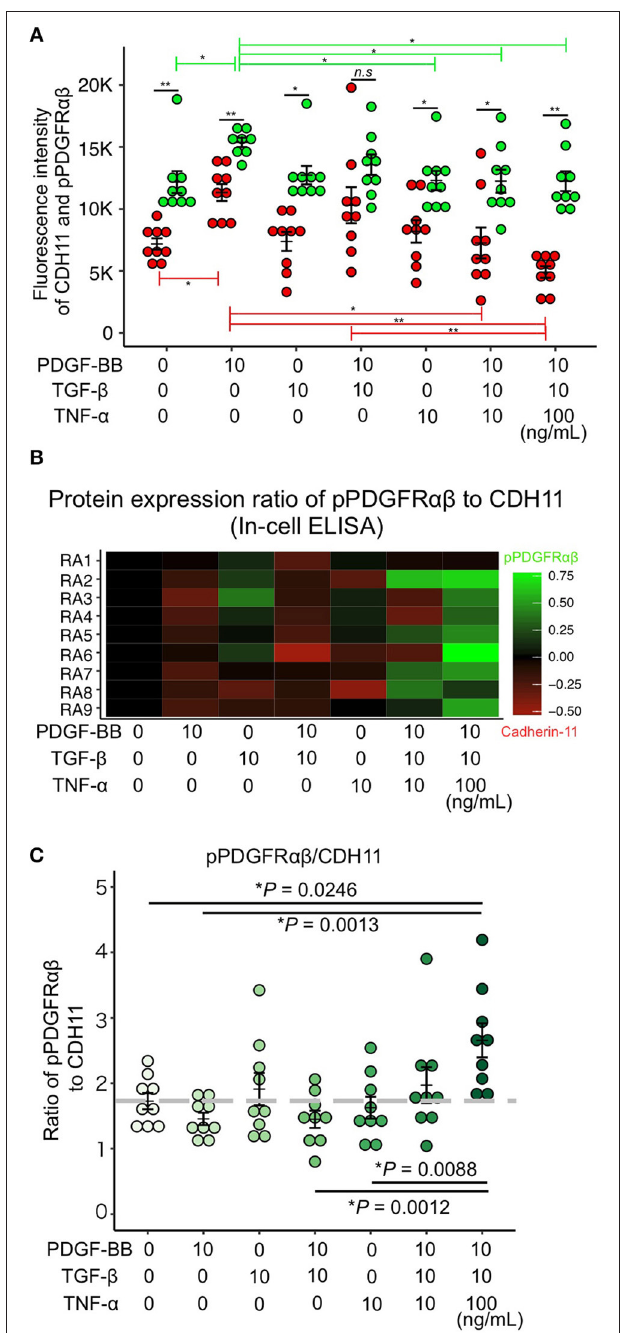
FIGURE 5 | PDGF-BB, TGF- β , and TNF- α stimulation of RA-FLS resulted in predominant pPDGFR αβ expression. (A–C) quantitative data for pPDGFR αβ and CDH11 expression obtained by performing in-cell ELISAs. Stimulation with TNF in addition to 2GF reduced CDH11 expression, but not pPDGFR αβ expression. Stimulation with 2GF reduced the pPDGFR αβ /CDH11 ratio and elevated CDH11 expression. Stimulation with 2GF + TNF caused concentration-dependent increases in the pPDGFR αβ /CDH11 ratio and elevated pPDGFR αβ expression. One-way ANOVA was used for statistical analysis, and the Tukey–Kramer method was used to compare the groups. The significance level was P < 0.05. * P < 0.05; ** P <